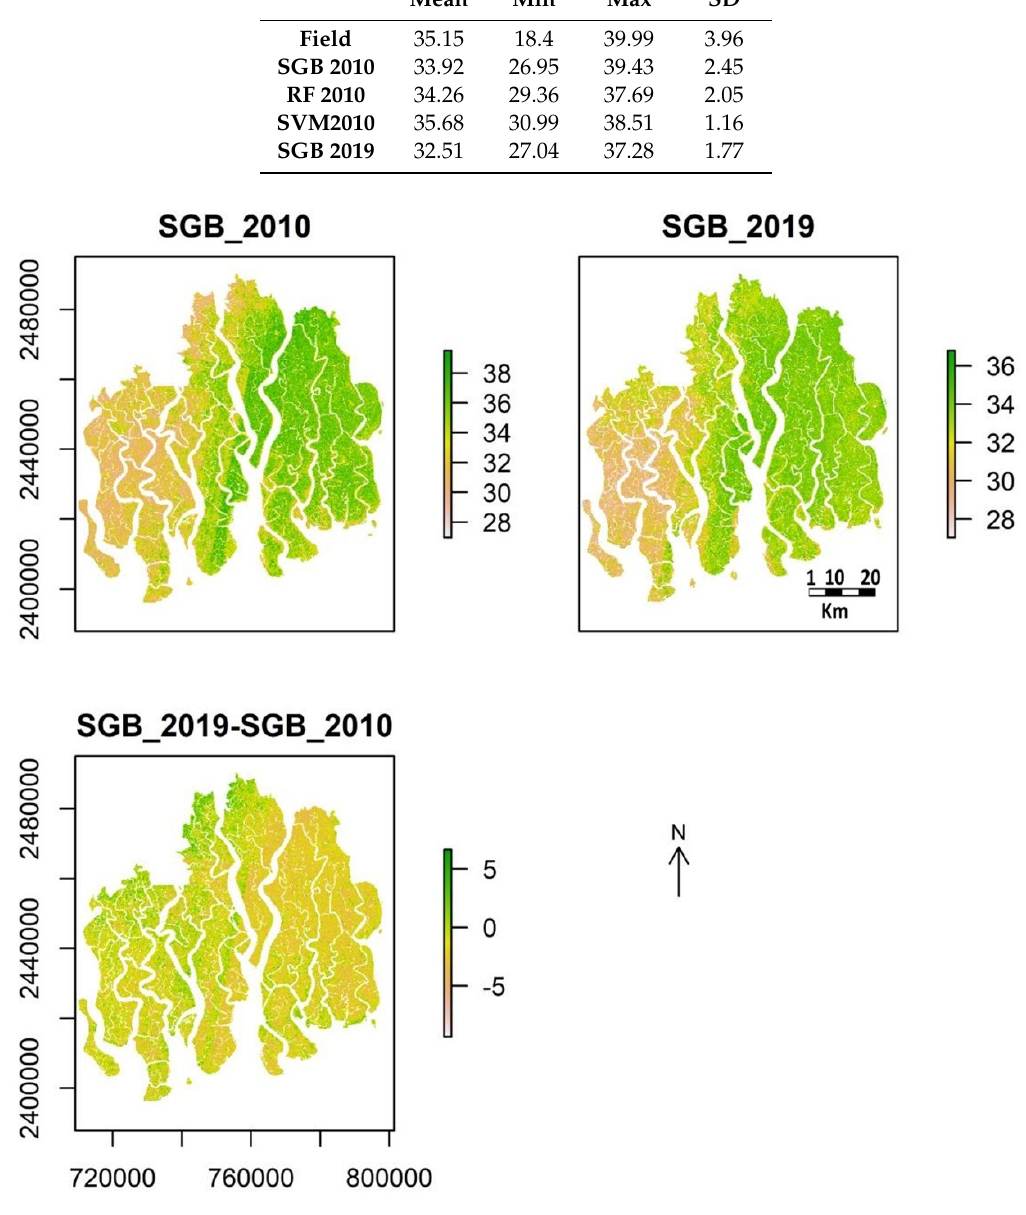
Table 6. Comparision between spatial statistics (models based) and field C:N ratio. SGB: Stochastic gradient boosting, RF: Random Forest and SVM: Support Vector Machine.